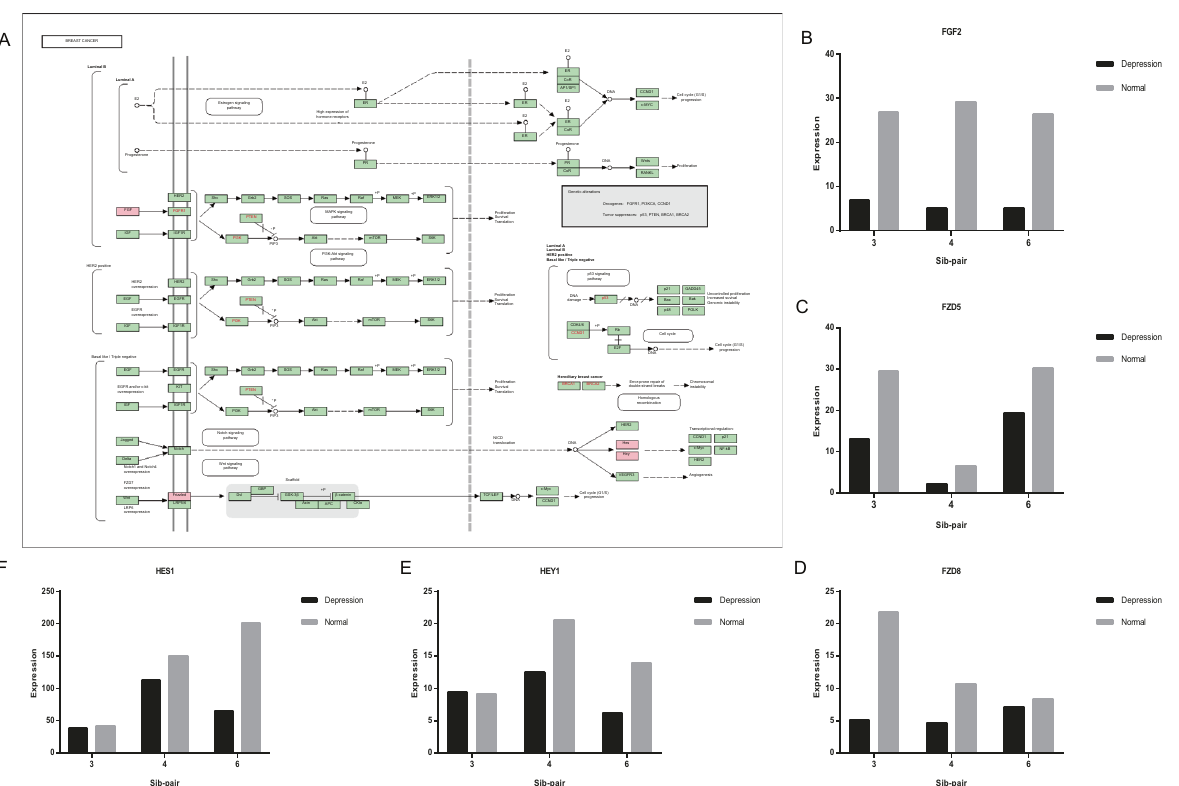
Fig. 4 Breast cancer pathway and the expression values of differentially expressed genes (DEGs) in the pathway in third, fourth and sixth sib-pair. A Schematic diagram of the breast cancer pathway. The red rectangle markers indicate the family of DEGs in the pathway, which are FGF2 , FZD5 , FZD8 , HEY1, and HES1 . B The expression of FGF2 gene in the third, fourth, and sixth sib-pair. C The expression of the FZD5 gene in the third, fourth, and sixth sib-pair. D The expression of FZD8 gene in the third, fourth, and sixth sib-pair. E The expression of HEY1 gene in the third, fourth, and sixth sib-pair. F The expression of the HES1 gene in the third, fourth, and sixth sib-pair. Black denotes depressed individual of sib-pair and gray indicates normal individual. The x-axis represents the sib-pair number and the y-axis represents the expression values of the